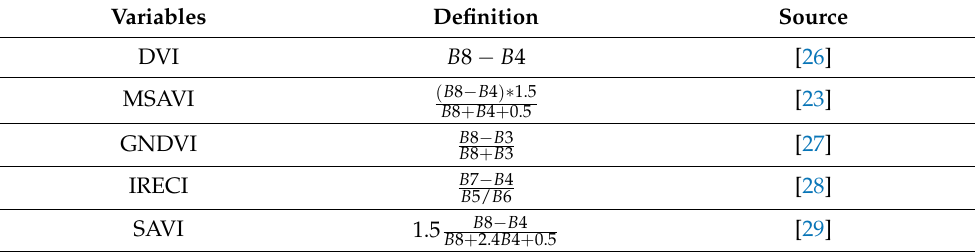
Table 3. Sentinel 2 data-derived